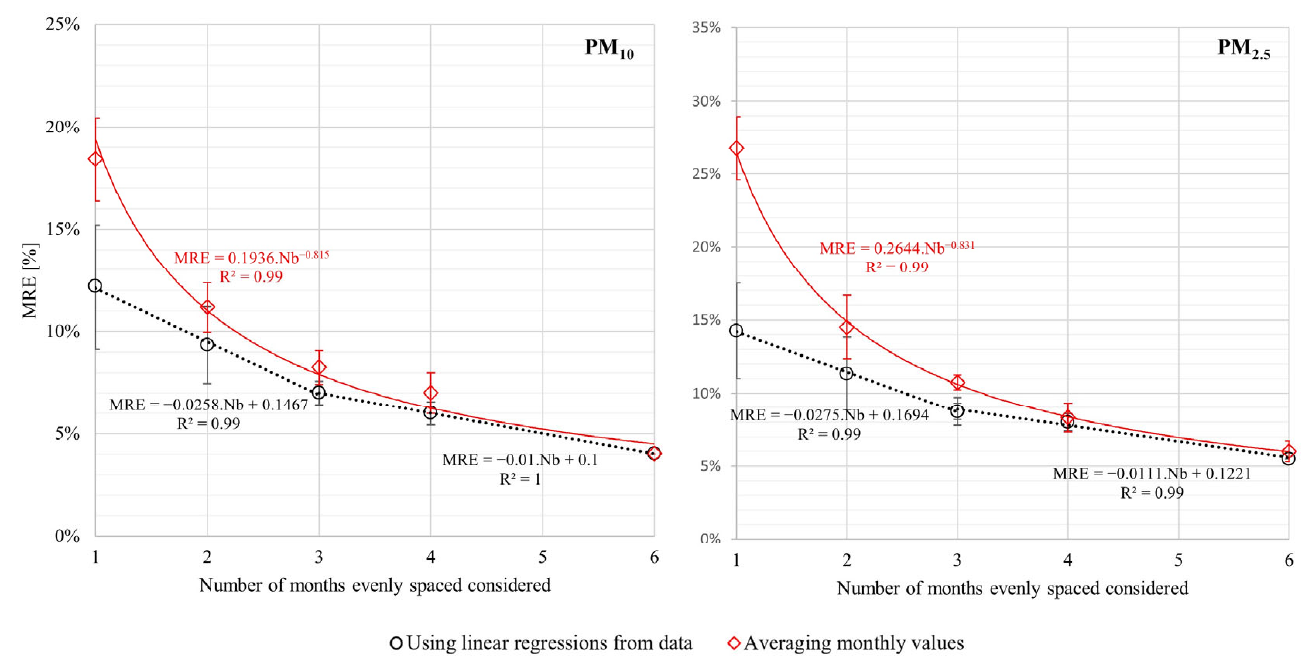
Figure 6. Evolution of the mean relative error (A) depending on the number of months for PM 10 ( left ) and PM 2.5 ( right ) when using the linear regression and directly averaging.